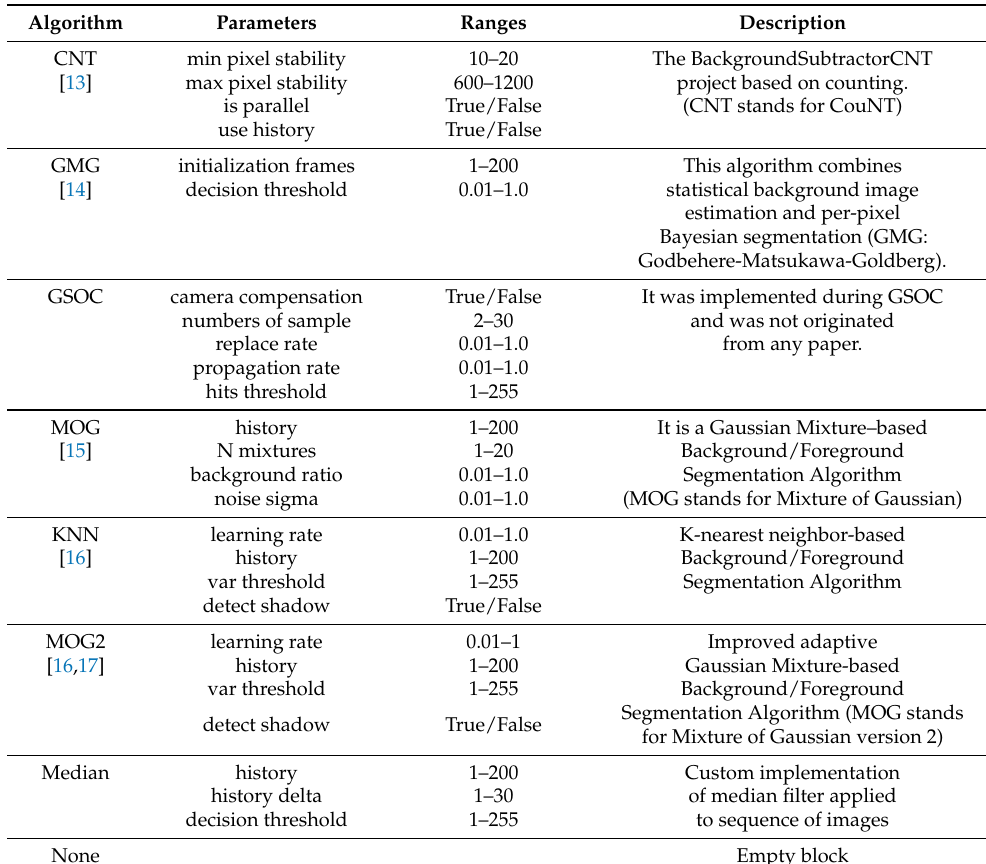
Table 1. Background estimation algorithms applied in the optimization